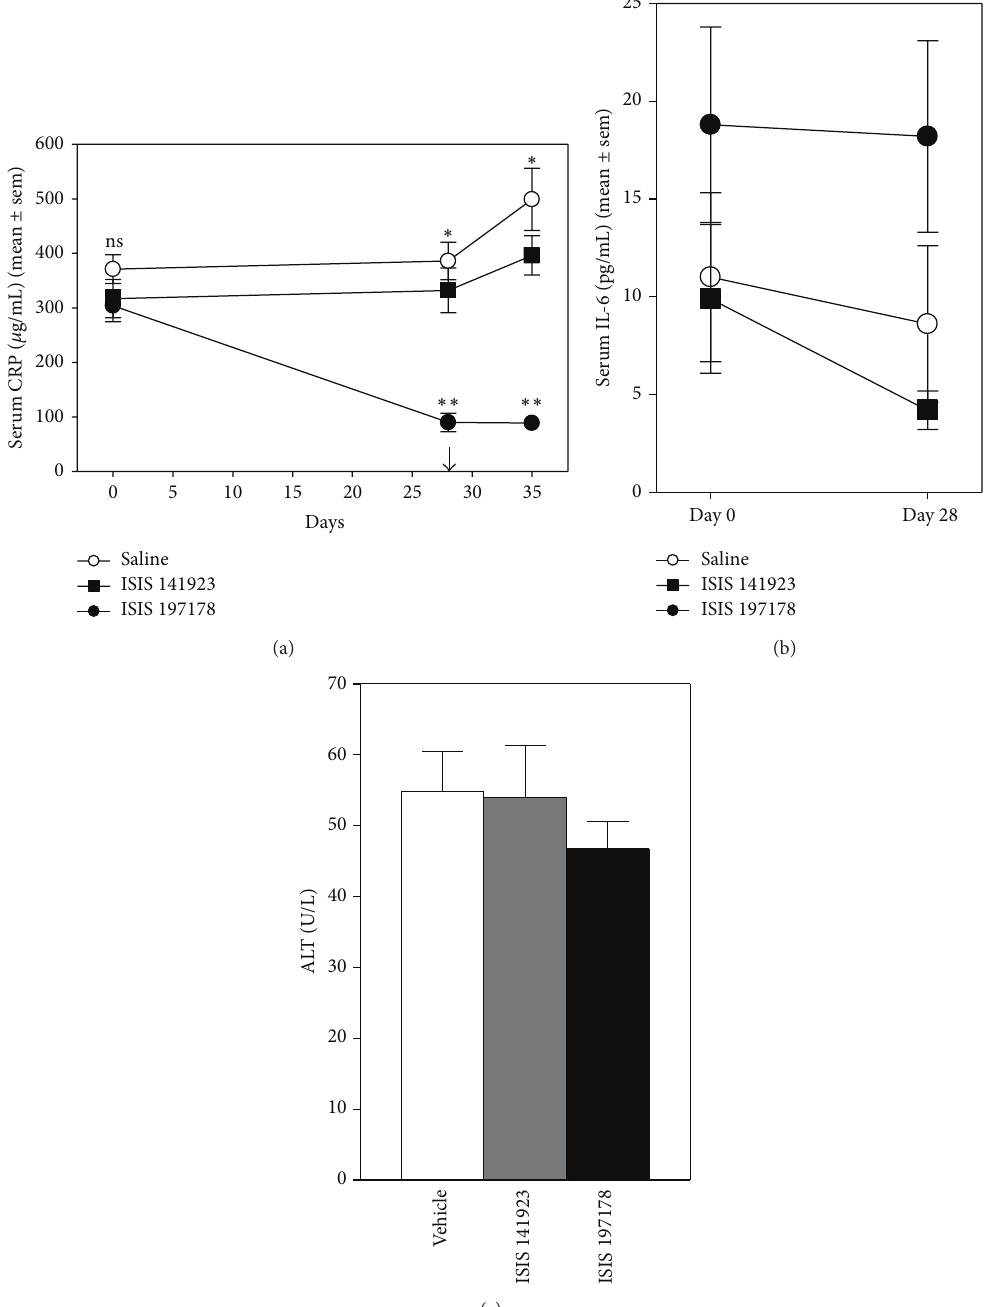
Figure 1: ASO-mediated lowering of CRP in rats subjected to LADCA ligation. (a) Serum CRP values determined by ELISA for rats injected i.p. with a CRP targeting ASO (ISIS 197178; 150mg/kg/wk, 𝑛 = 19 ) ( ◼ ), a control ASO (ISIS 141923; 150 mg/kg/wk, 𝑛 = 9 ) ( ◻ ), or an equivalent volume of 0.9% saline (vehicle, 𝑛 = 8 rats) ( I ). The arrow indicates the day LADCA ligation surgery was performed. The single asterisks and “ns” above the curves indicate 𝑃 < 0.0001 or not significant (𝑃 > 0.05) , respectively, for ANOVAs comparing the three treatment groups on each day. The double asterisks below the lines indicate 𝑃 < 0.0001 for protected least-squares difference tests comparing the ISIS 197178 treated group to both other groups. (b) Serum IL-6 determined by ELISA for the rats shown in (a). (c) Serum alanine transaminase (ALT) levels determined by ELISA on day